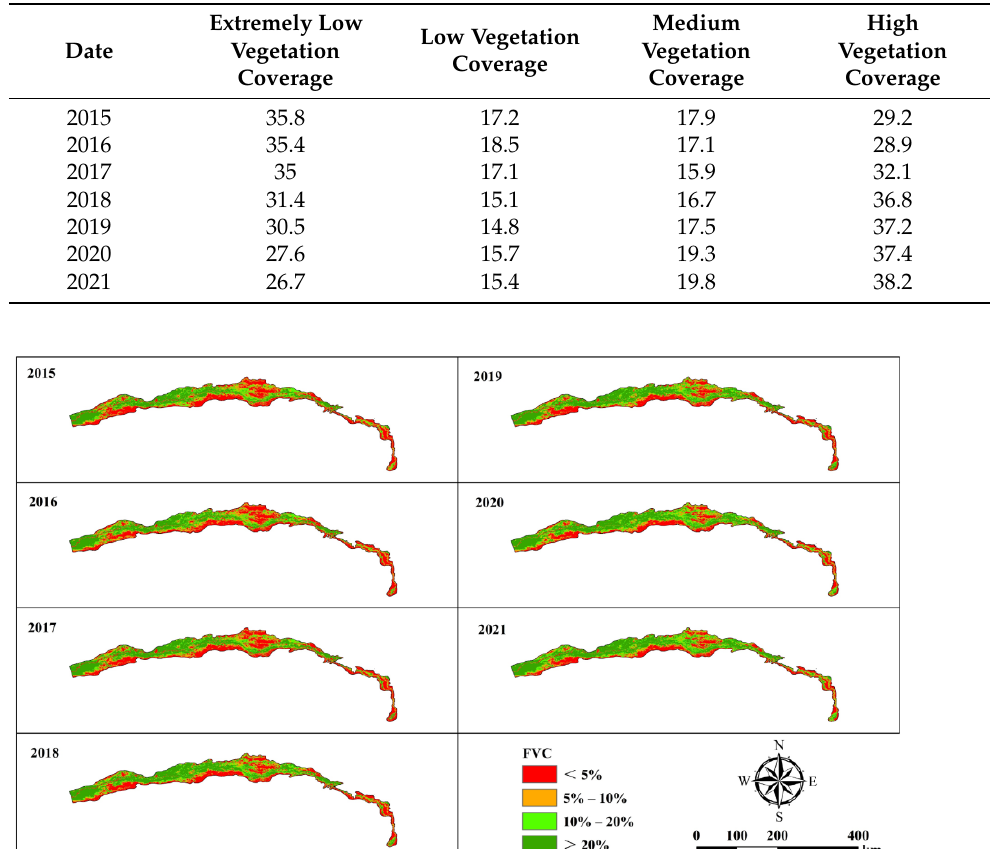
Figure 7. Spatial distribution of vegetation coverage grades in the mainstream area of the Tarim River from 2015 to 2021.